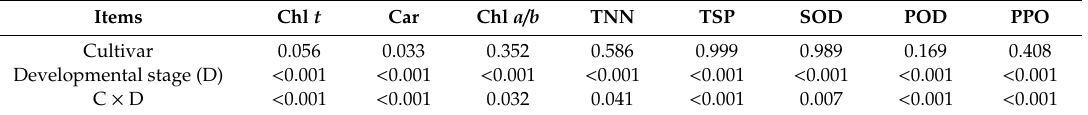
Table 5. The analysis of variance (ANOVA) results ( p value) of cultivar × development on selected composition traits of barley grass.